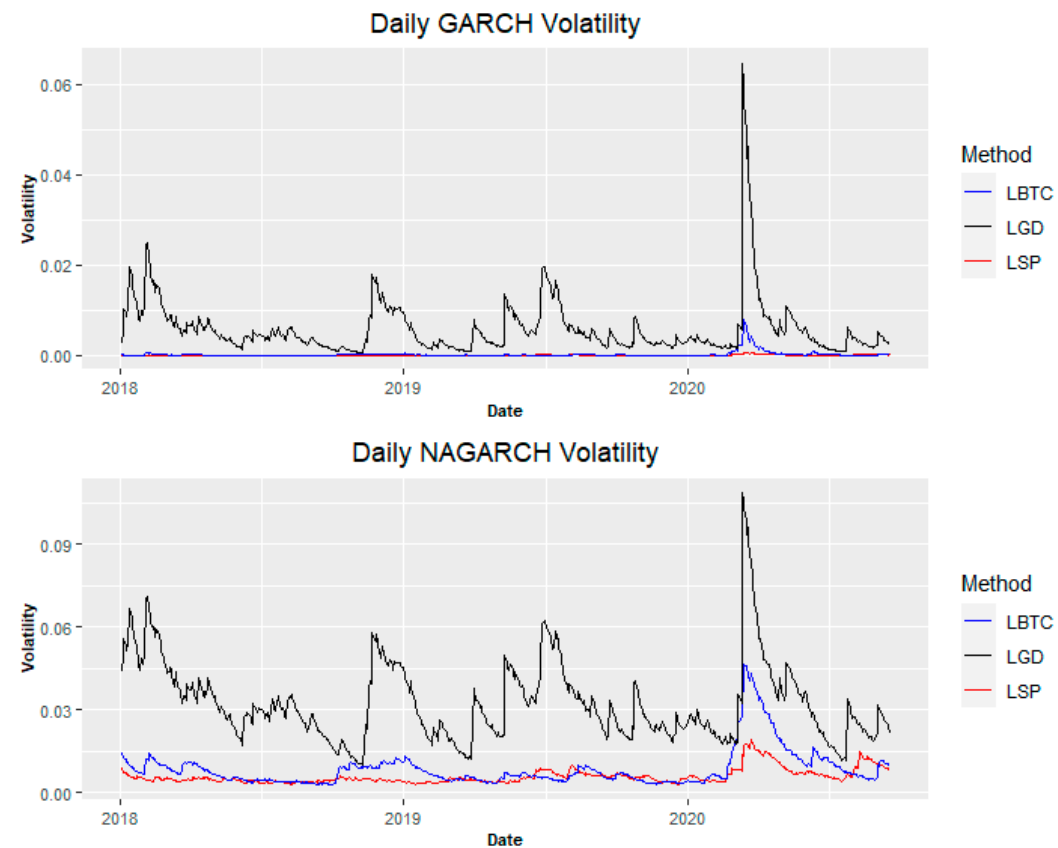
Figure 2. Daily volatility plots for LBTC, LSP, LGD with GARCH (1, 1), and Nonlinear Asymmetric-GARCH (1, 1).